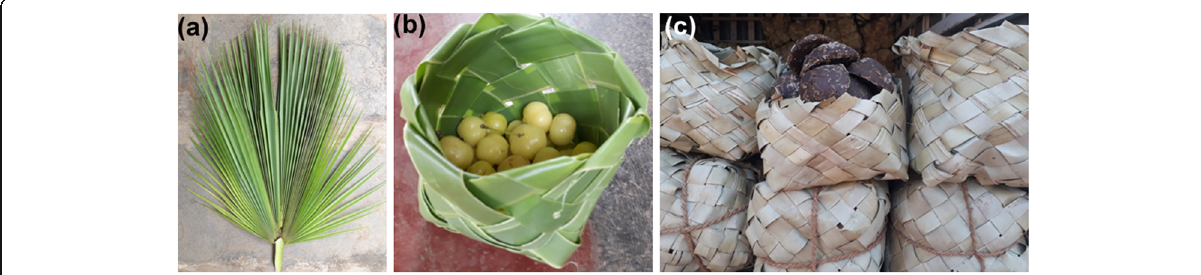
Fig. 8 a The leaves of thati , B. flabellifer , ( b ) hand oven leaf basket of made from thati is used for storing star gooseberry fruits and ( c ) packing of toddy jaggery in leaf baskets of